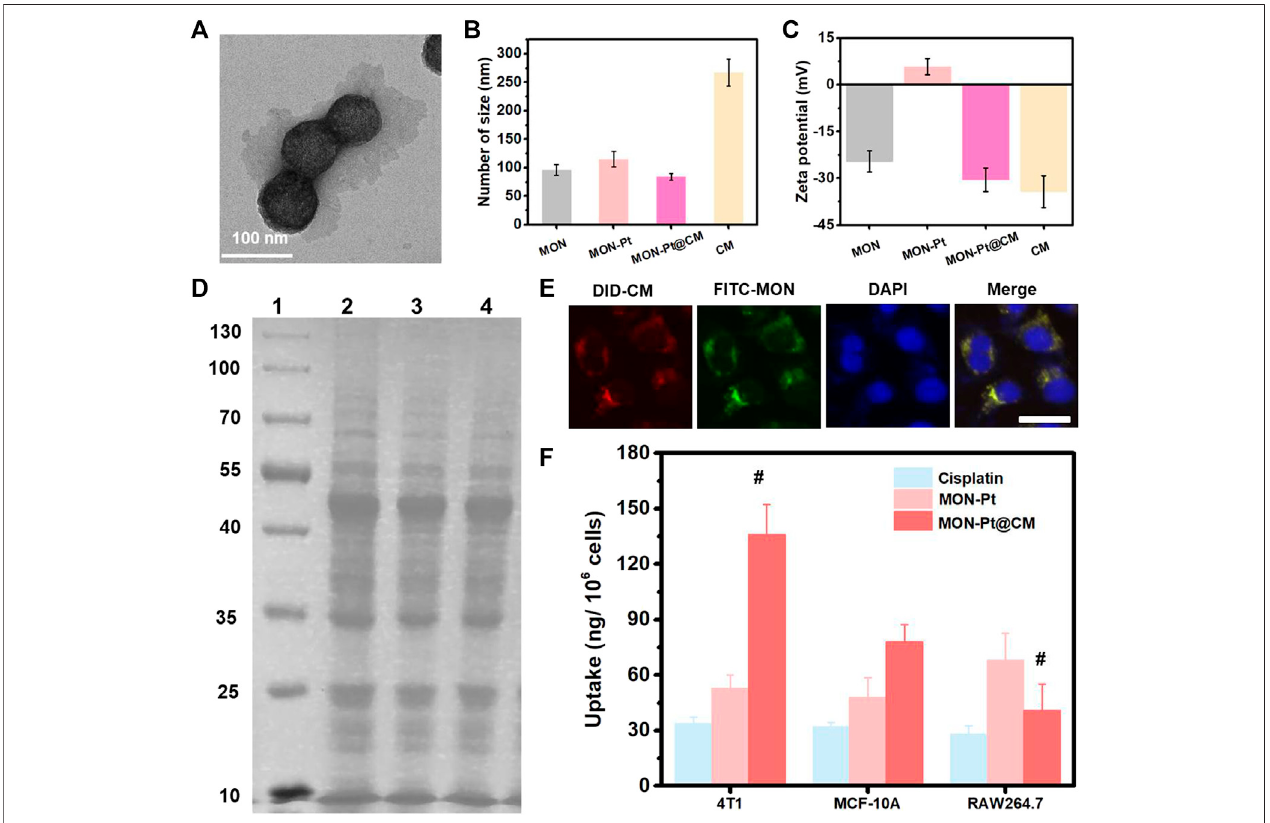
FIGURE 3 | Preparation and characterization of MON-Pt@CM. (A) TEM, (B) size, (C) zeta potential of MON-Pt@CM. (D) SDS-PAGE protein analysis. 1-well: marker, 10 – 130 kDa; 2-well: cell lysate; 3-well: CM vesicle; 4-well: MON-Pt@CM. (E) intracellular colocalization of DiD-labeled CM vesicles (red) and FITC-labeled MON (green) of FITC-MON-Pt@DID-CM in 4T1 cells after incubation for 1 h. Scale bars indicate 5 µm. (F) Selective uptake of MON-Pt@KP1339 in 4T1, MCF-10A, and RAW264.7 cells after incubation for 6 h # p < .05 compared with MON-Pt group.